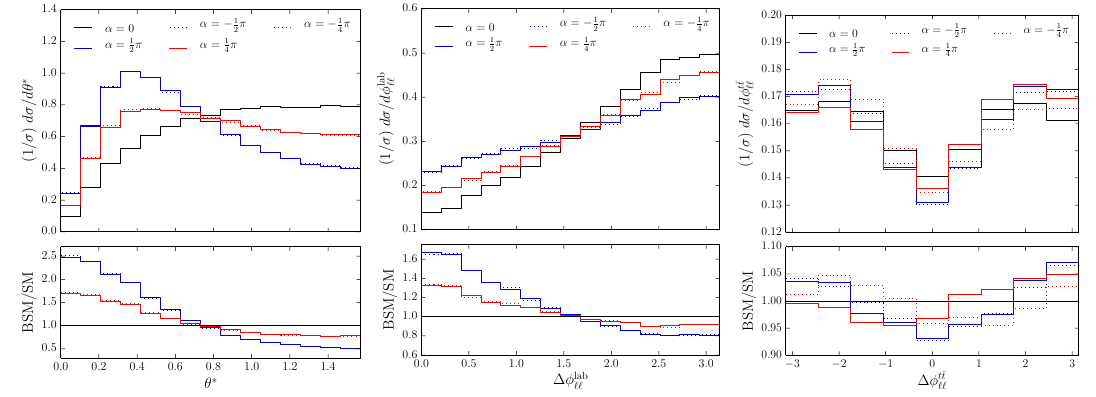
Figure 3 . θ ∗ (left), ∆ φ lab (middle), and ∆ φ t ¯ t (right) distributions for the t ¯ th samples at the 14 TeV ‘‘ ‘‘ LHC, after the basic cuts described in table 1, and resolving the combinatorial